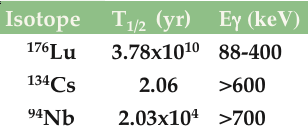
Table 2. First isotopes selected for in-plasma decay time